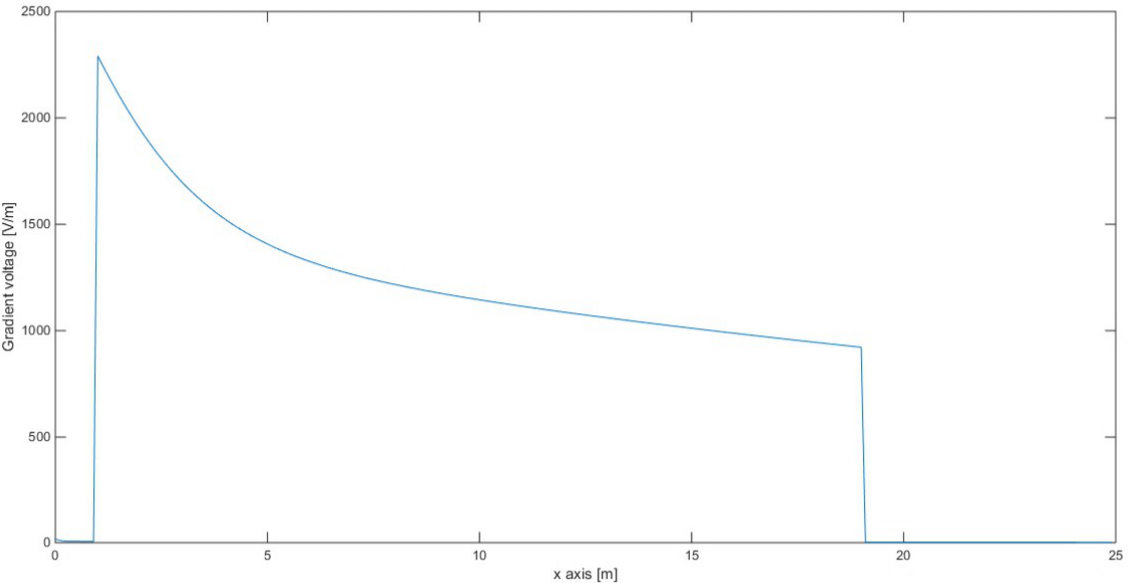
Figure 31. Electric field strength on the Ox semi-axis, perpendicular to the perceived axis of the electrode station, at the point of the maximum value of all absolute potentials, applying method “A” for the far field ( ρ S = ∞ ) and method “C” for the near field, with simplifying admissions ( ρ S = ∞ ), with compensation for the presence of a dam; for an electrode station of 6 linear frames in a row, with d frames = 6.50 m, each frame consisted of 13 electrodes of active length L = 2.13 m, D el = 0.50 m, ρ d = 100 Ω · m, ρ w = 0.25 Ω · m, θ w = 2.29 ◦ , θ = 248 ◦ (area of Korakia), J maitenance_steady = 22 A/m 2 (steady state and operation of 5 panels, except no.